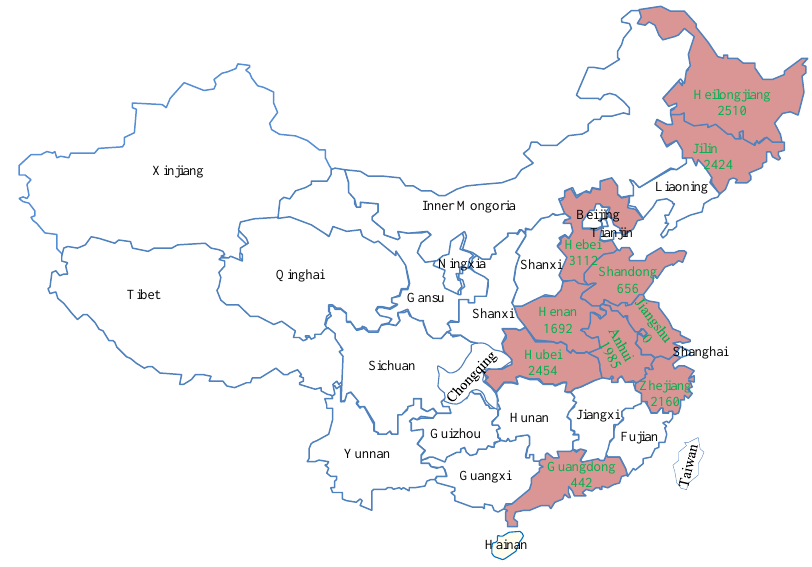
Figure 1. The provinces of China considered in the analysis with the ten most efficient ones shaded in red. Numbers indicate the gains in biomass sector profits if economic efficiency is maintained without property